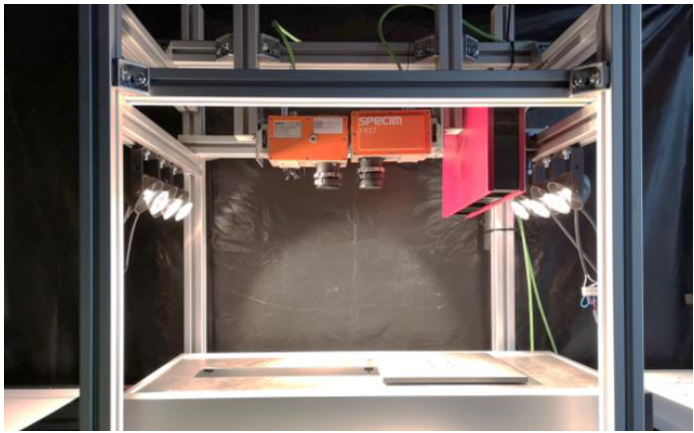
Figure 2. Measuring setup consisting of hyperspectral cameras, linear stage, illumination unit and 3D structured light scanner.